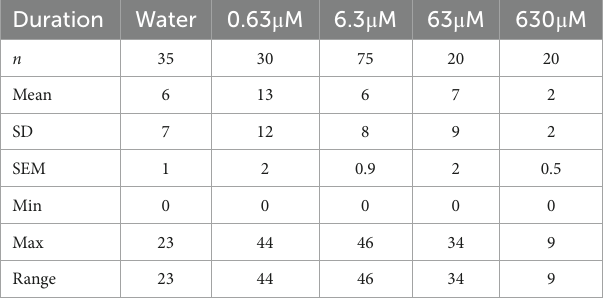
TABLE 2B Statistical analysis of nicotine dose-dependency - frequency in nicotine